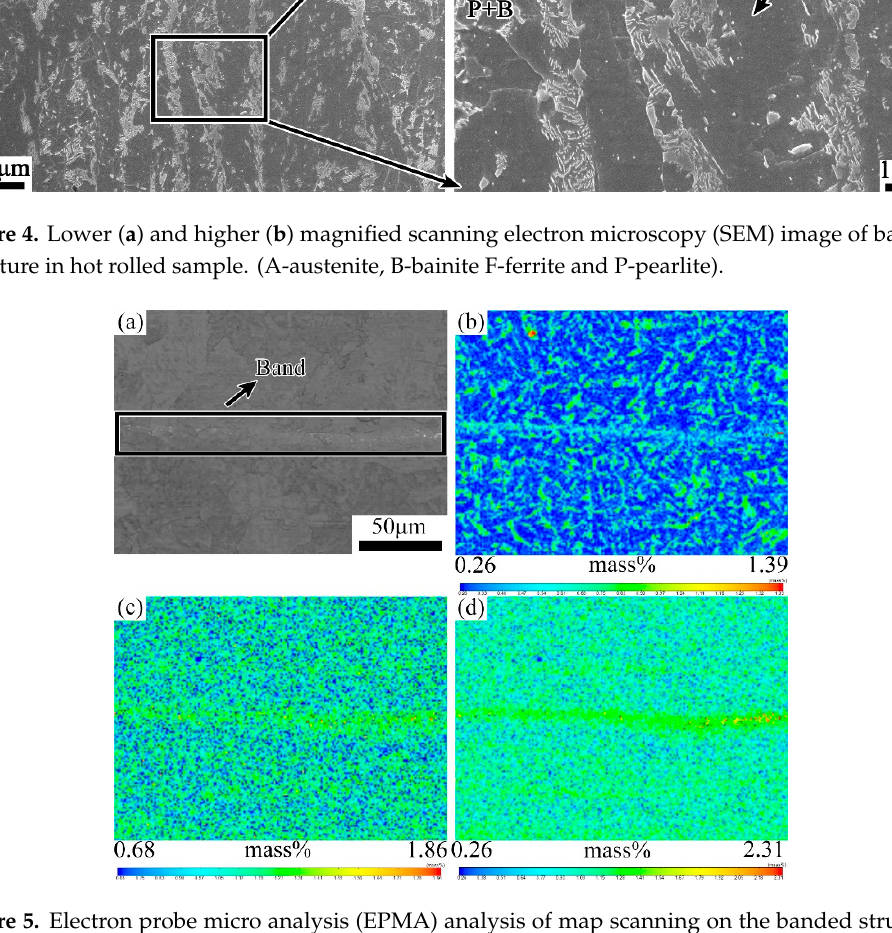
Figure 5. Electron probe micro analysis ( EPMA) analysis of map scanning on the banded structure of hot rolled sample. ( a ) Optical micrograph of the banded structure; ( b ) EPMA maps of element C; ( c ) EPMA maps of Cr; ( d ) EPMA maps of Mo.